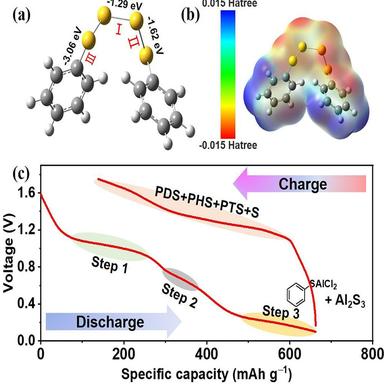
(a) The molecular bond energies of different S-related bonds in PTS. (b) The molecular electrostatic potential of PTS. (c) The reaction schematic of PTS in the Al||PTS battery.